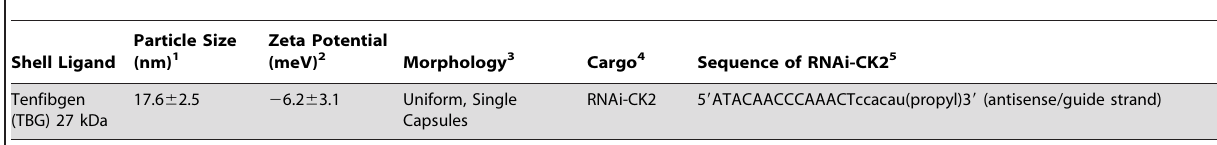
Table 1. In Vivo Nanocapsule Characteristics and Information.